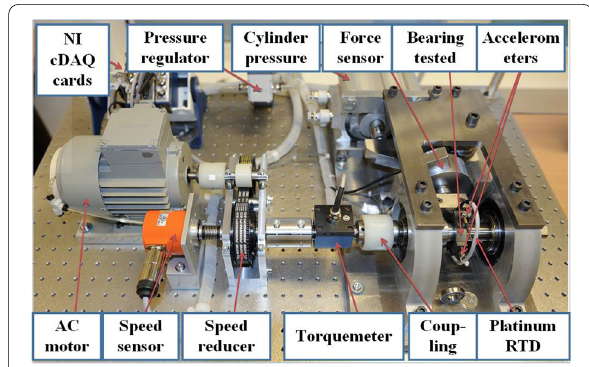
Figure 4 PRONOSTIA platform